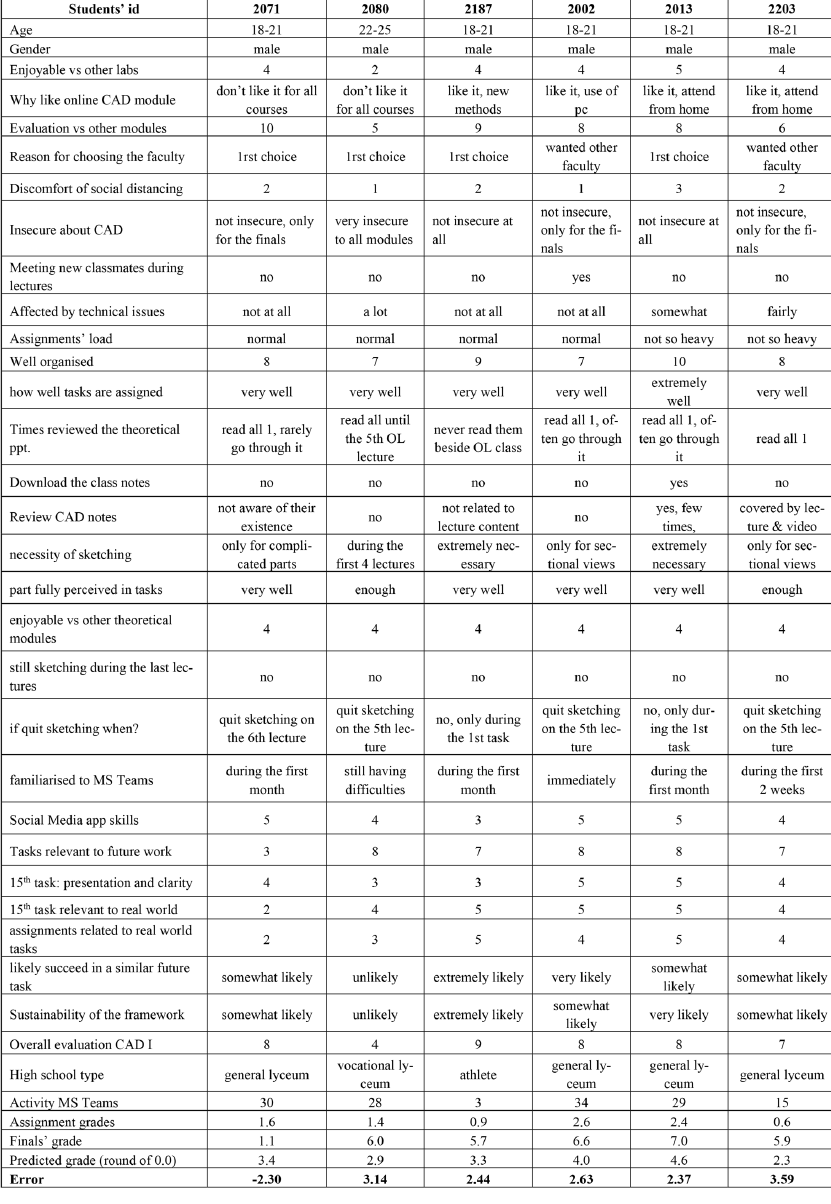
Fig. 9. Students with lower prediction